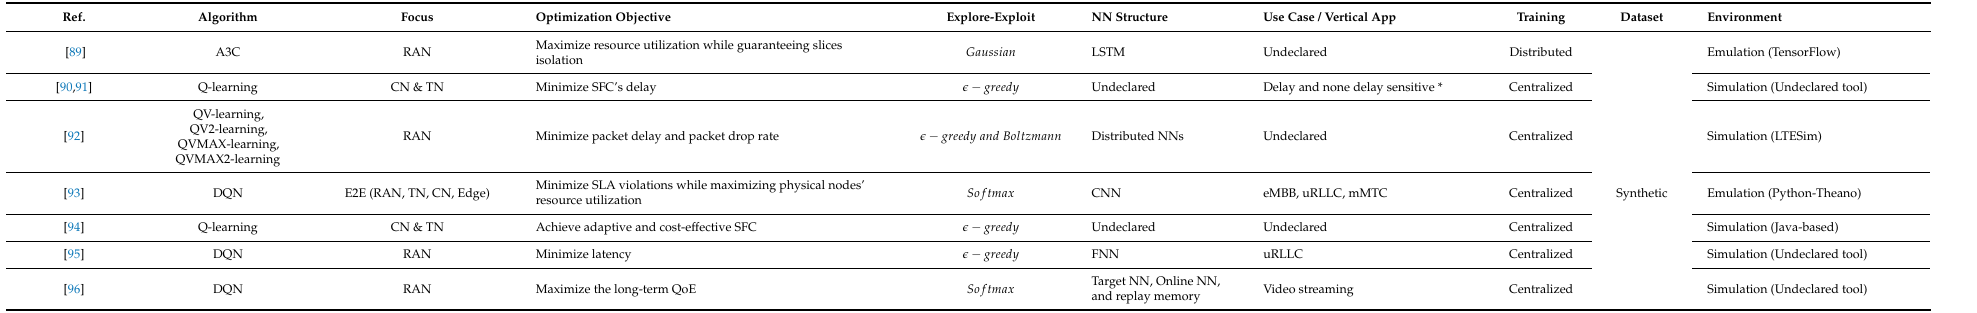
Table 5. Resource scheduling based on RL and